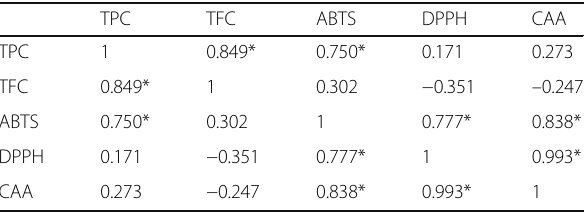
Table 3 Pearson correlation analysis for antioxidant components and activities of MP leaf